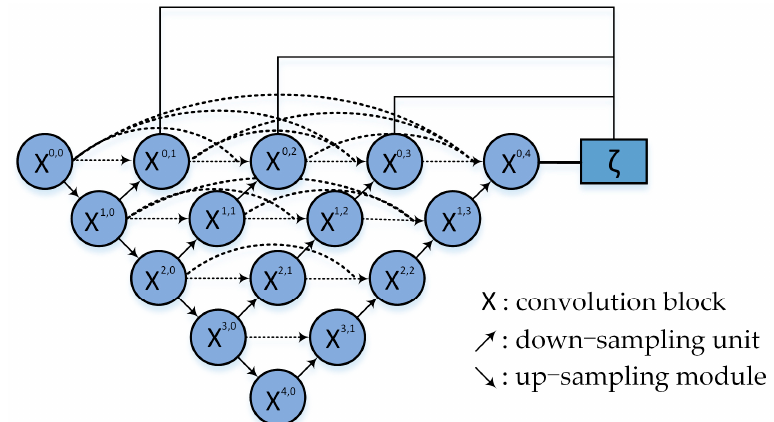
Figure 8. Network structure of UNet++.